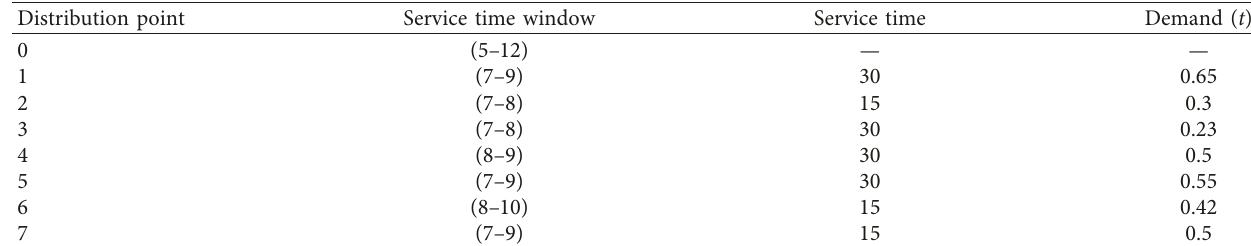
Table 2: Customer time window range and demand.